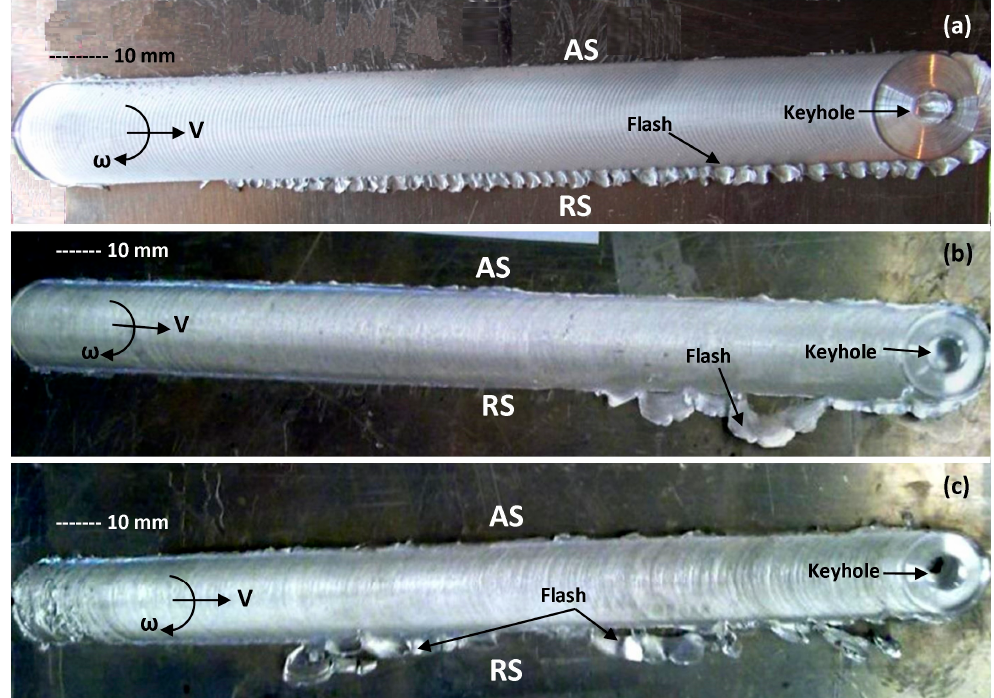
Figure 6. Surface appearance of the weld for different FSW tool in constant speed sets of (250 mm/min and 1400 rpm); ( a ) conical pin profile, ( b ) square pin profile and ( c ) threaded pin profile.